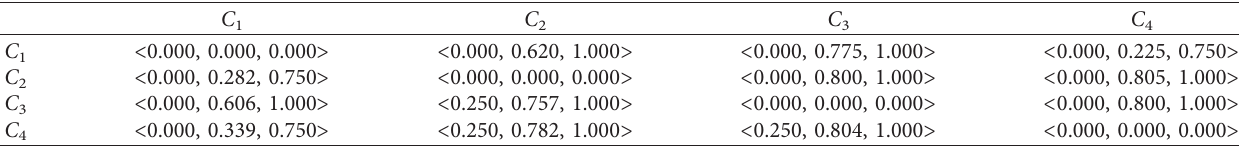
Table 2: TFN matrix A .